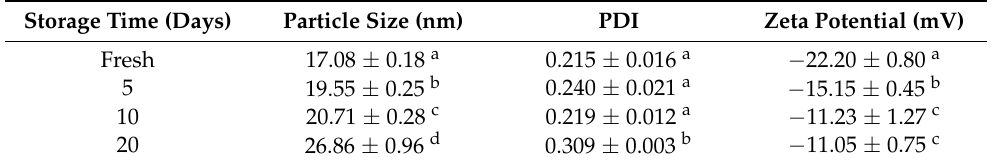
Table 2. Characterization of nanoemulsions with different storage times at room temperature: evaluation of particle size, PDI, and zeta potential of nanoemulsions.